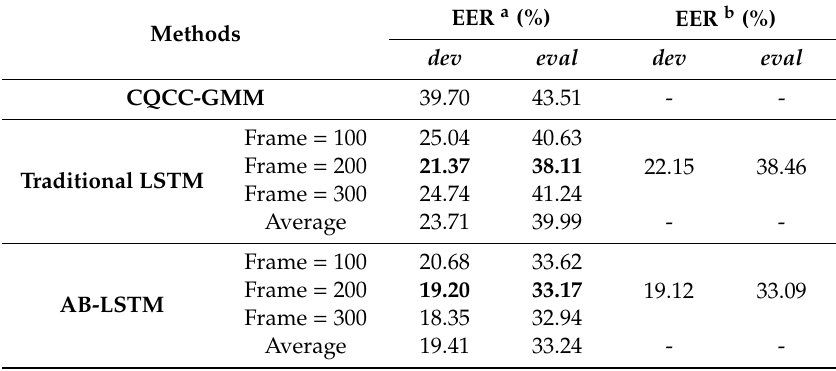
Table 5. EER a (%) and EER b (%) for di ff erent methods when SNR = 0 dB.